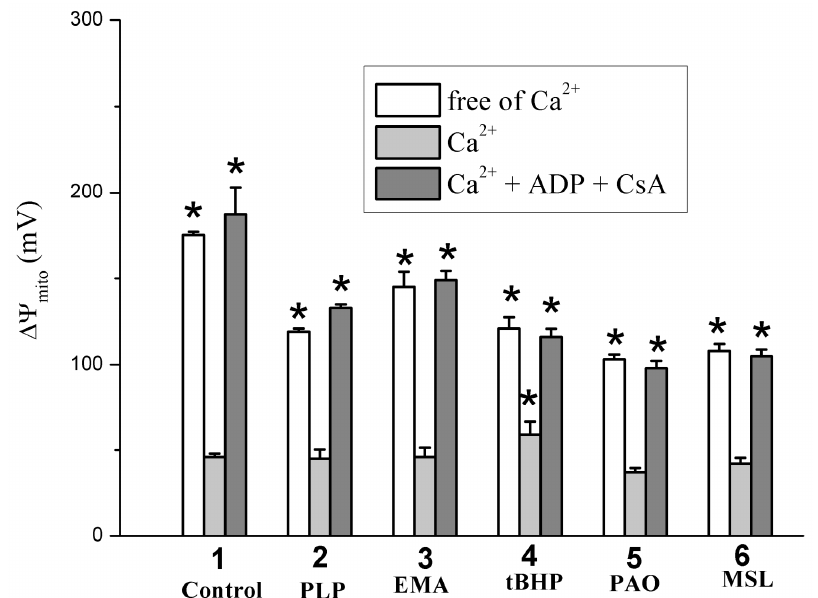
Figure 4. The influence of Ca 2+ , pyridoxal 5-phosphate, and thiol reagents on the inner membrane potential ( ∆Ψ mito ). Mitochondria (0.5 mg/mL of protein) were injected into the medium containing 20 mM TlNO 3 , 125 mM KNO 3 , 110 mM sucrose, 5 mM Tris-NO 3 (pH 7.3), 1 mM Tris-P i , 2 µ M rotenone, 3 µ M safranin O, and 1 µ g/mL of oligomycin. The ordinate shows ∆Ψ mito change (mV) calculated from the safranine O fluorescence intensity (see section 4). Numerals on the abscissa indicate the used reagents: control experiments (1), 6 mM PLP (2), 10 µ M EMA (3), 100 µ M t BHP (4), and 2 µ M PAO (5). Besides, 500 µ M ADP and 1 µ M CsA (where indicated) were correspondingly added into the medium before mitochondria and Ca 2+ . Next, 75 µ M Ca 2+ was injected into the medium after mitochondria. * shows significant differences from the control experiments with Ca 2+ and free of the reagents ( p < 0.05).